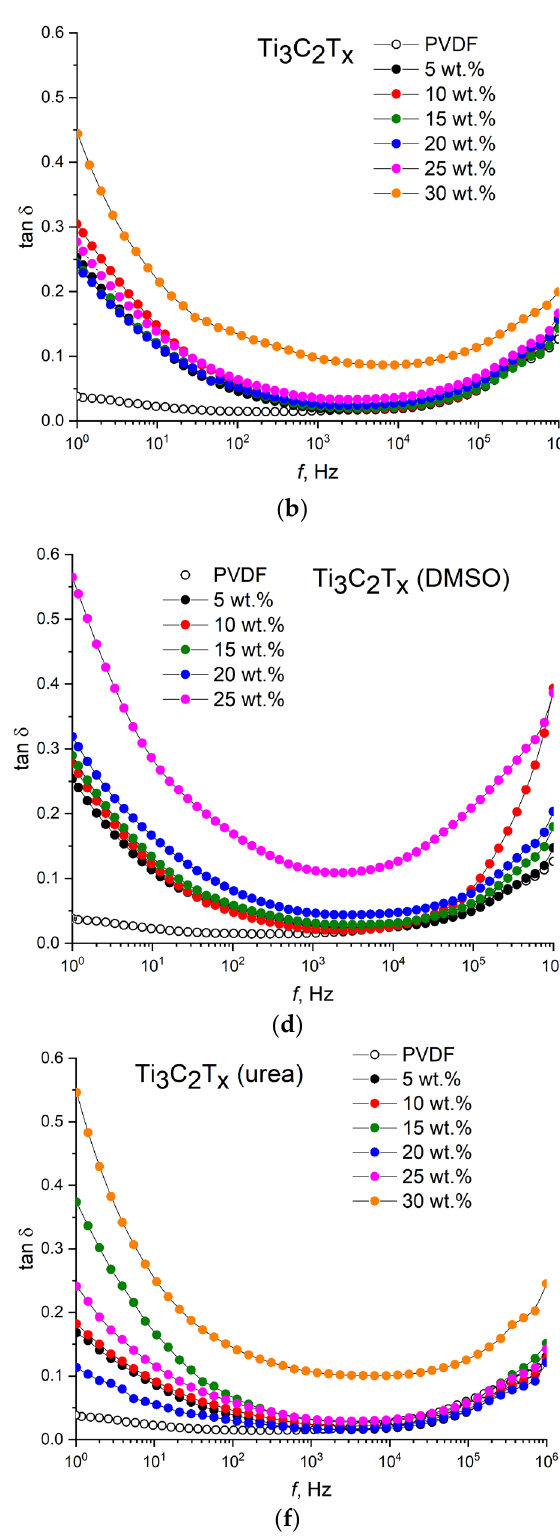
( f ) Figure 4. SEM images using primary electrons (left) and secondary electrons (right) of cross sections of ( a , b ) PVDF/Ti 3 C 2 T x , ( c , d ) PVDF/Ti 3 C 2 T x (DMSO), and ( e , f ) PVDF/Ti 3 C 2 T x (urea) with a filler